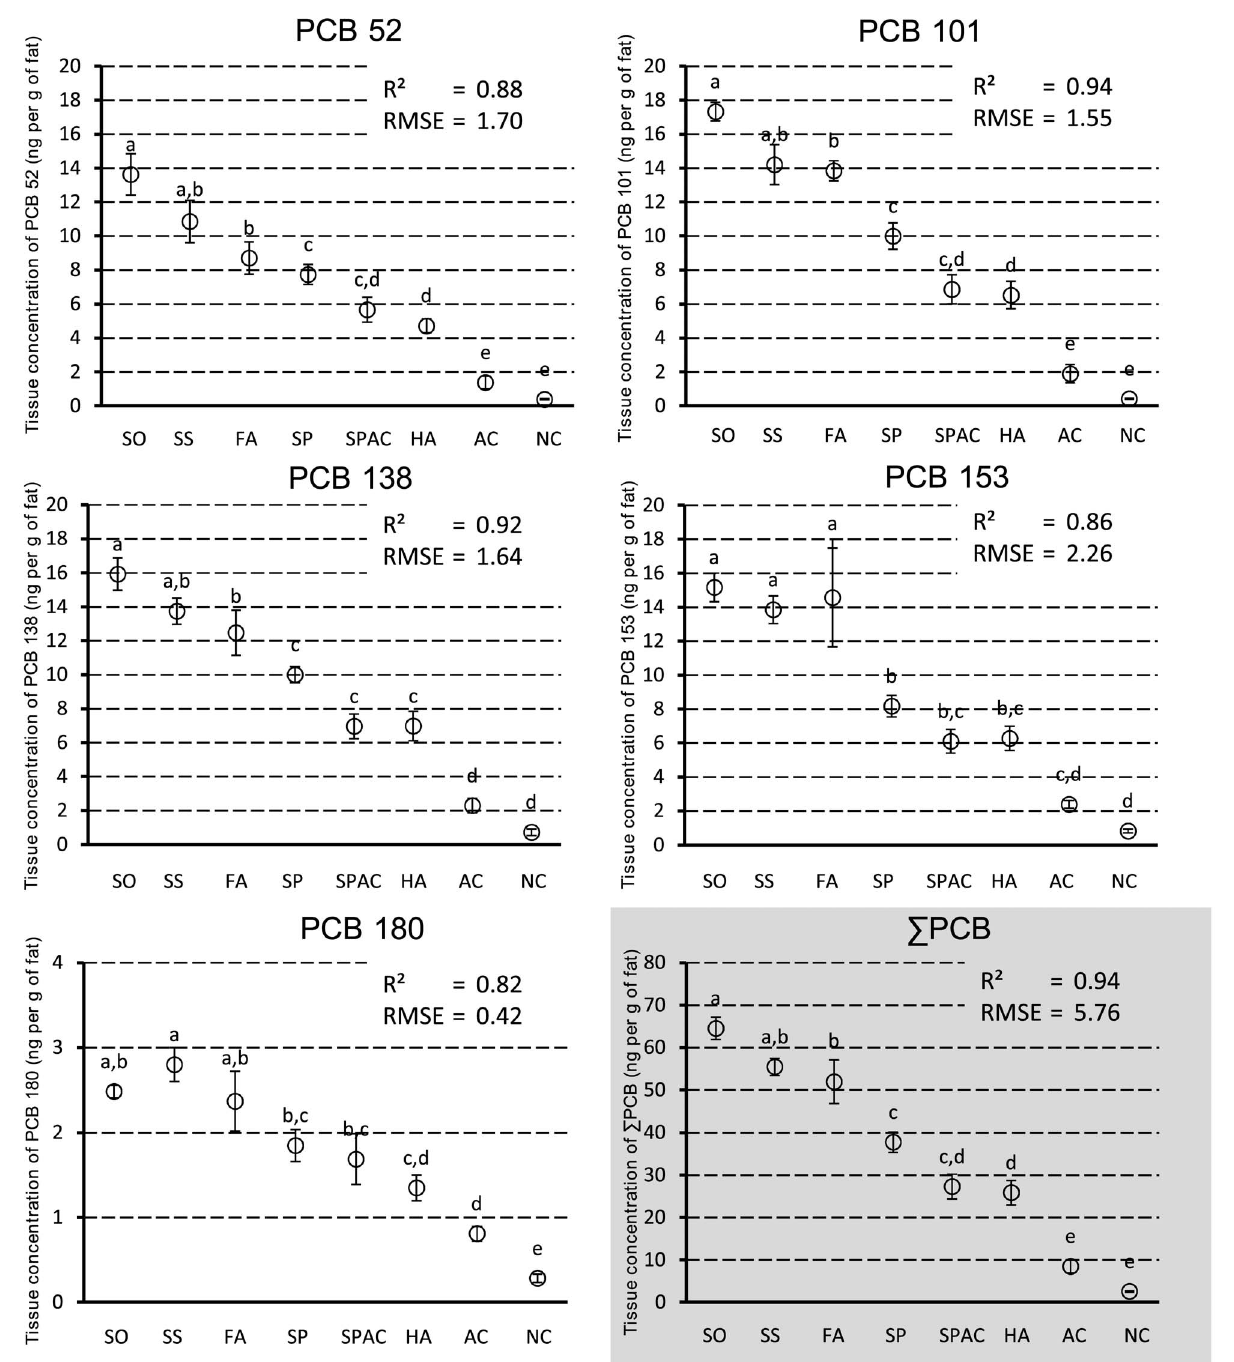
Fig. 2. Concentrations (ng.g 2 1 of fat) of NDL-PCBs in adipose tissue. Each value represents the adjusted mean ¡ standard error. Values are presented following treatment groups: Spiked corn oil (SO, n 5 5); Standard soil without organic matter (SS, n 5 4); 1% OC Fulvic acid soil (FA, n 5 4); 1% OC Sphagnum peat soil (SP, n 5 5); 1% OC Sphagnum peat soil; Activated Carbon (95:5) (SPAC, n 5 5); 1% OC Humic acid soil (HA, n 5 5); 1% Activated carbon (AC, n 5 5); Negative controls (NC, n 5 5). Letters (a, b, c, d, e, f) indicate values that do not statistically differ from other values within groups presenting a common letter ( P ,